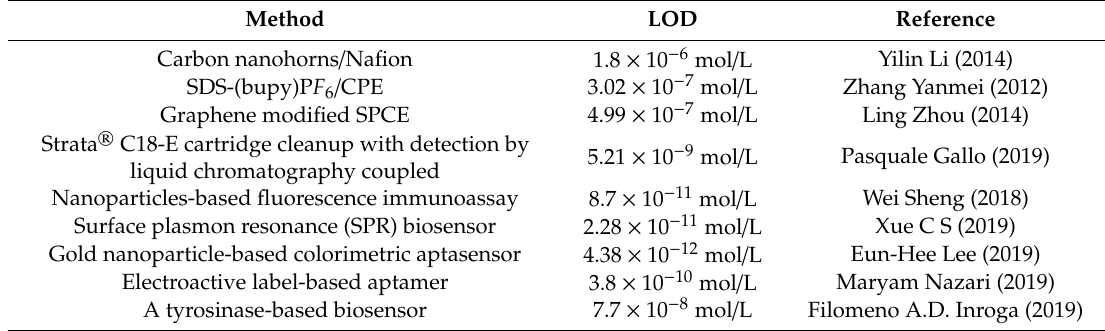
Table 1. Limit of detection (LOD) comparison of different methods.